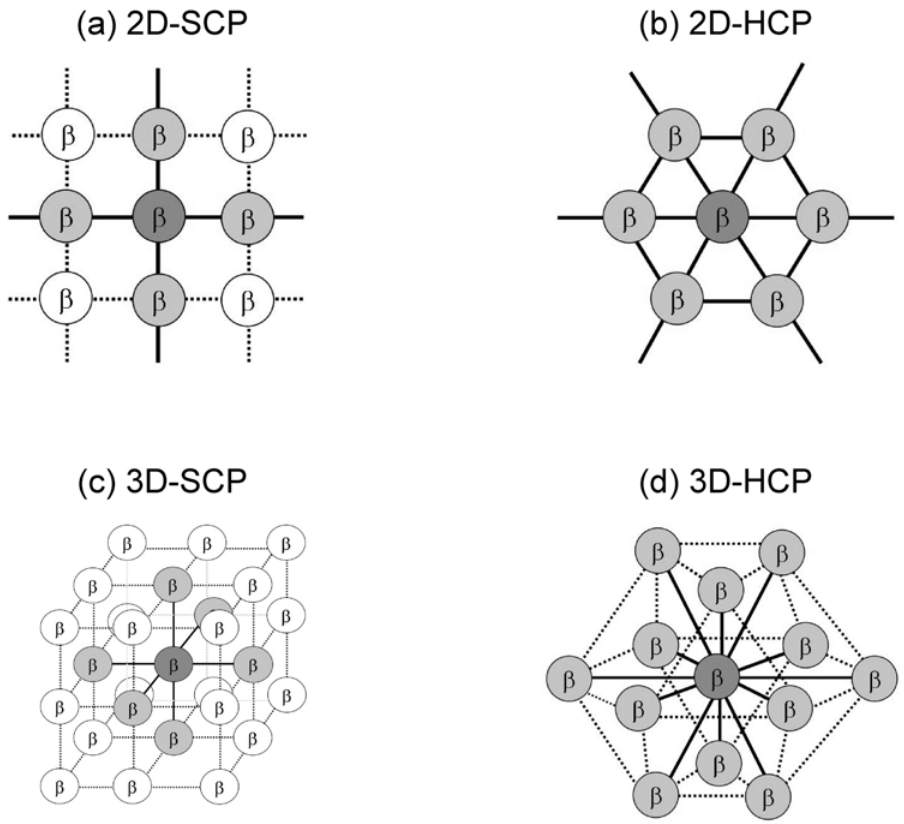
Figure 9. SCP and HCP b -cell clusters. In a 2D cluster n c =4 for SCP (a) and n c =6 for HCP (b). In 3D the numbers become n c =6 for SCP (c) and n c =12 for HCP (d).